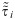
Spatial distribution of the neighborhood set LIMA τ~~i of six consecutive pairs of the six hours per day periods in Jianghan, Wuhan, China: (a) 2–6 to 6–10; (b) 6–10 to 10–14; (c) 10–14 to 14–18; (d) 14–18 to 18–22; (e) 18–22 to 22–2; and (f) 22–2 to 2–6.